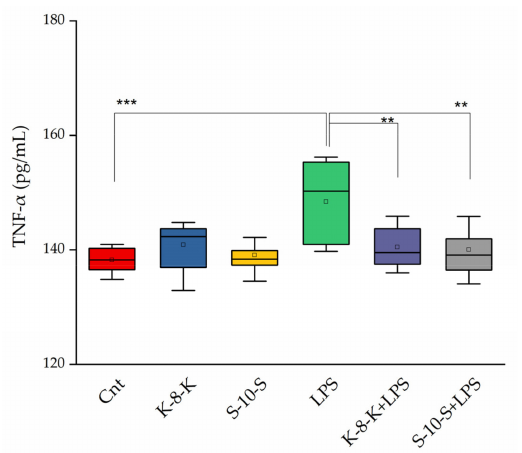
Figure 5. Effect of K-8-K and S-10-S on the inflammatory response in Caco-2 cells treated with 0.01 mg/mL LPS. The levels of TNF- α were measured by ELISA assay in supernatants of Caco-2 cells grown for 14 days and pretreated with the peptides (0.05 mg/mL) for 24 h. Here, 0.01 mg/mL LPS was used as inflammatory stimulus. Means of at least three replicates estimated in duplicate were compared (*** p < 0.001, ** p < 0.01). Cnt: untreated cells.